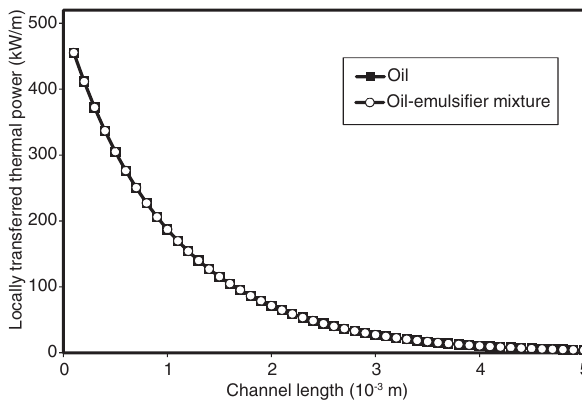
Figure 8 Transfer of thermal power in an ideal co-current flow µHX (only the transferred thermal power along the first 5 mm of the channel length is shown).